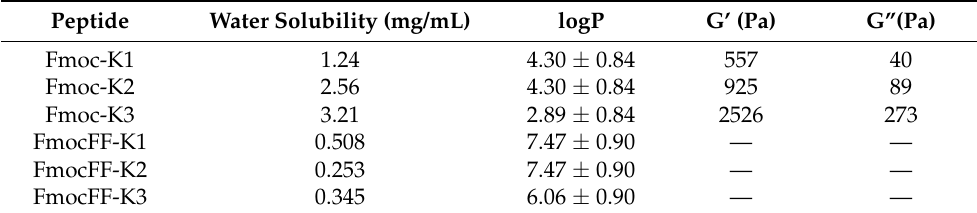
Table 2. Water solubility, logP values, water solubility, storage modulus (G’) and loss modulus (G”) of the investigated